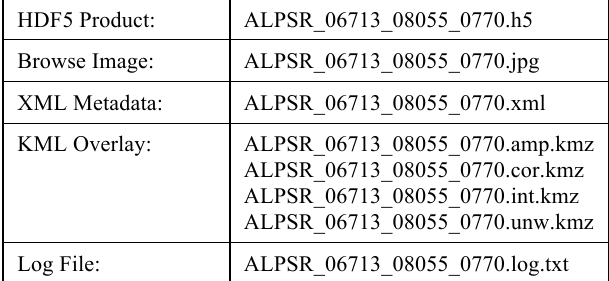
Table 8. Example files included in the sample standardized InSAR products.